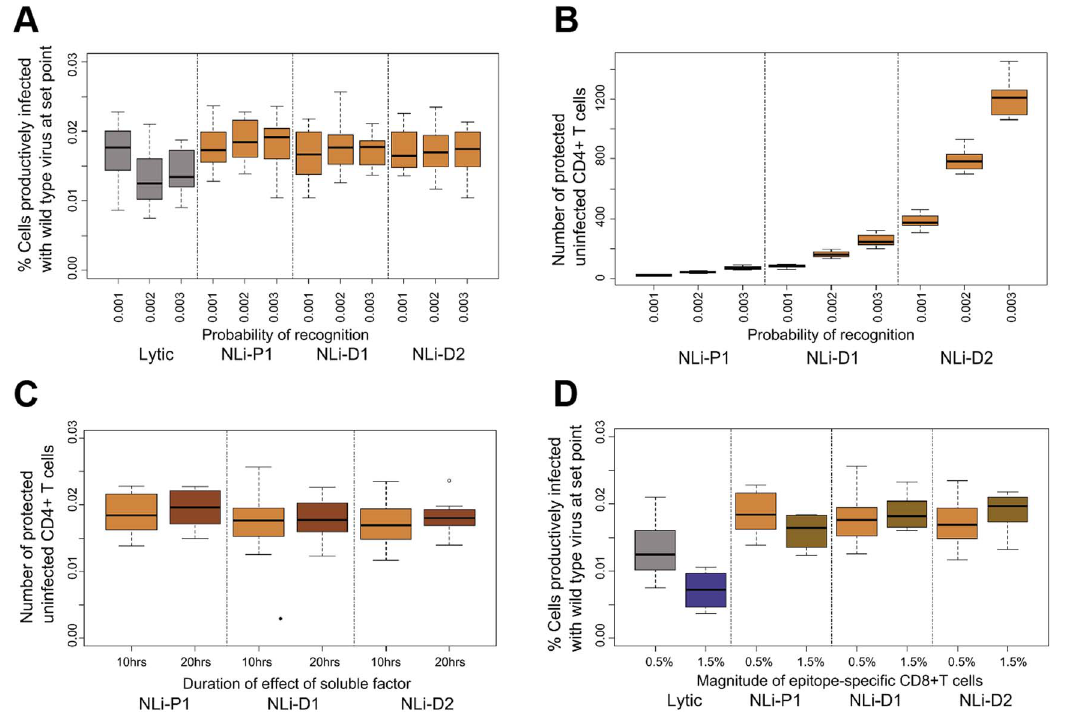
Figure 5. The immune control exerted by lytic and non-lytic CD8 + T cell responses. ( A ) The frequency of productively infected cells at setpoint for varying probability of CD8 + T cell recognition and for different secretion patterns. As the probability of recognition increases, the frequency of infected cells decreases for the lytic response but remains approximately constant for the non-lytic response for all secretion patterns. When Pr=0.001 (first box) the frequency of infected cells is similar for the lytic and non-lytic responses ( B ) Number of uninfected CD4 + T cells protected from infection by a non-lytic CD8 + T cell response. The number of cells protected increases significantly as the probability of recognition and the area of diffusion increases (cumulative number by 50 dpi). ( C ) Set-point of productively infected cells when varying the duration of the protective effect of the soluble factor. Number of infected cells at setpoint does not decrease when the duration of effect is increased even though the number of cells protected robustly increases ( D ) Set-point of productively infected cells for different sizes of the epitope-specific CD8 + T cell clones. Here we show the results for the non-lytic control that blocks viral infection, similar results were found for non-lytic control that blocks viral production (Figures S6, S7 in Text S1 and data not shown). Results for more extensive parameter combinations are shown in supplementary information (Figures S10 and S11 in Text S1). The percentage of productively infected cells is calculated from 40–50 dpi. Abbreviations: NLi: Non-lytic model - blocking infection of uninfected CD4 + T cells, P1=Polarised secretion (r=1), D1=Diffusive secretion (r=1) and D2=Diffusive secretion